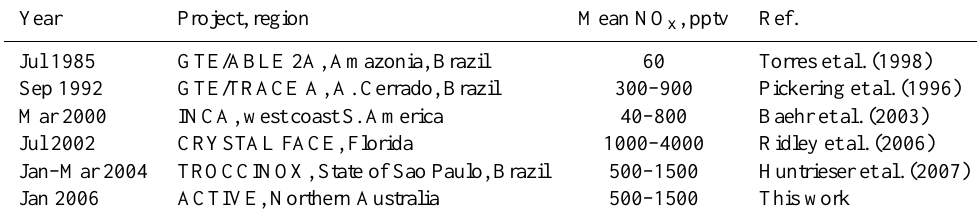
Table 2. Mean NO x enhancements for selected field campaigns in the tropics.